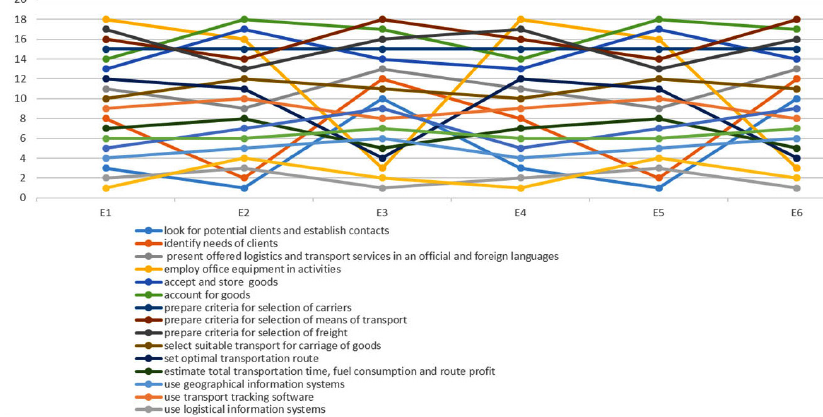
Figure 4. Distribution of competencies necessary for logistics forwarders after expert ranking (compiled by the